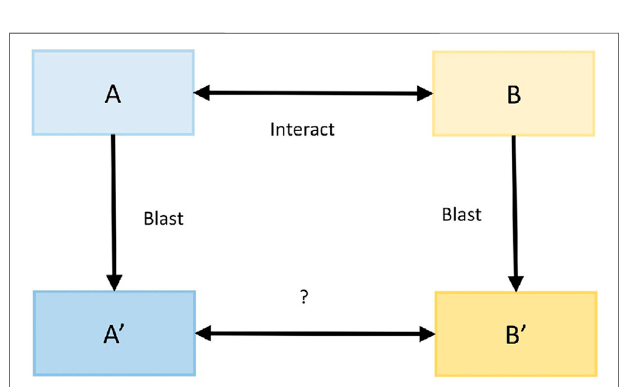
FIGURE 4 | Interolog